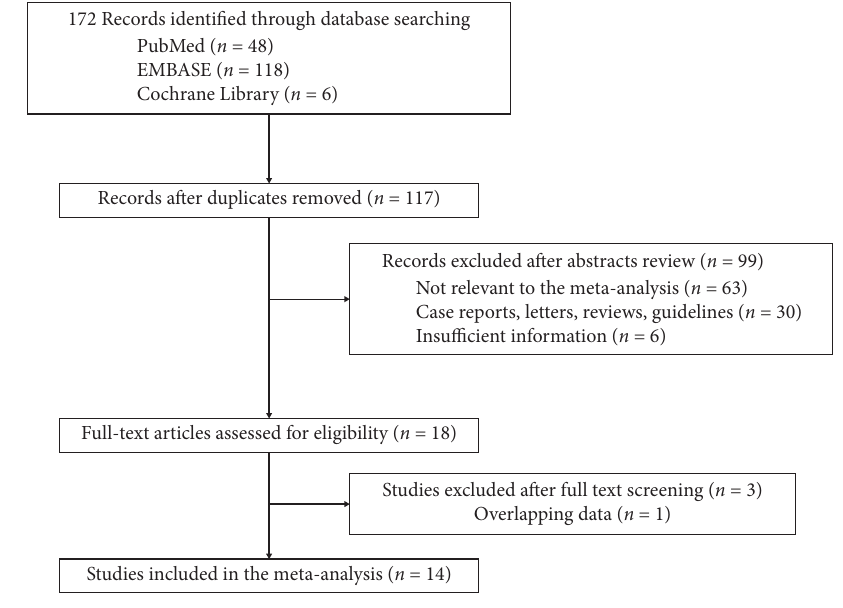
Figure 1: Flow diagram of the identification process for eligible studies. Table 1: Characteristics and methodological quality